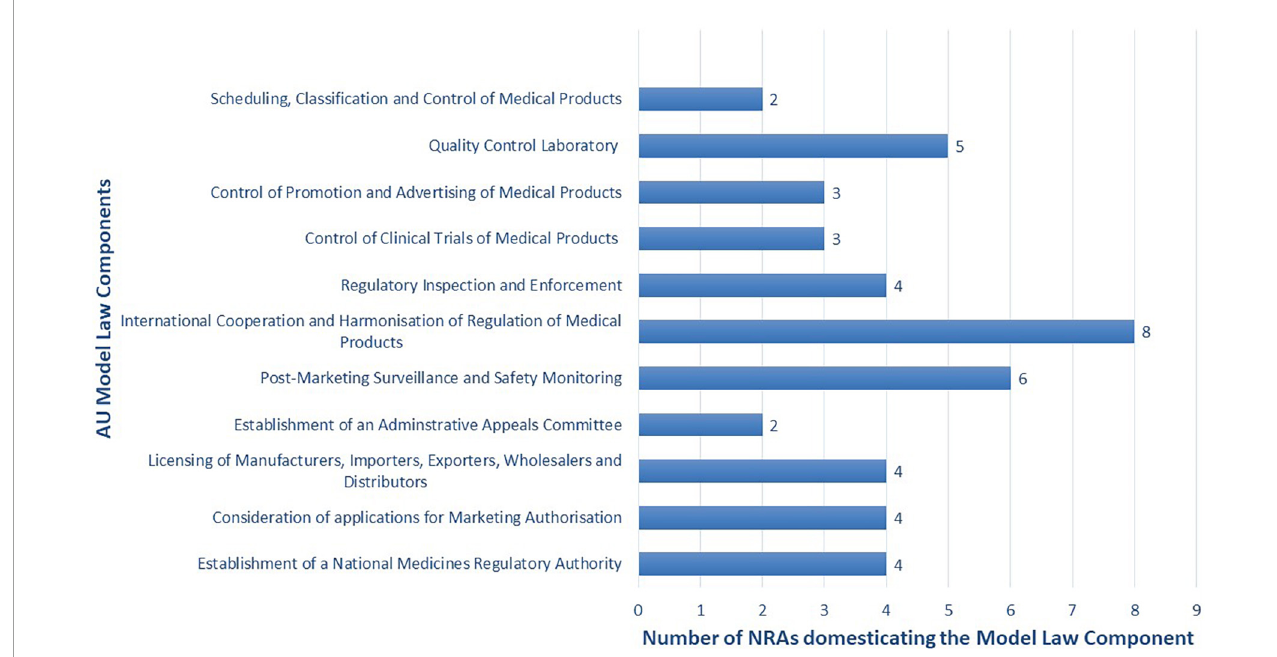
FIGURE4 Components of the model law adopted or being adopted by the eight African national medicines regulatory authorities (NRAs) performing a partial domestication ( N =